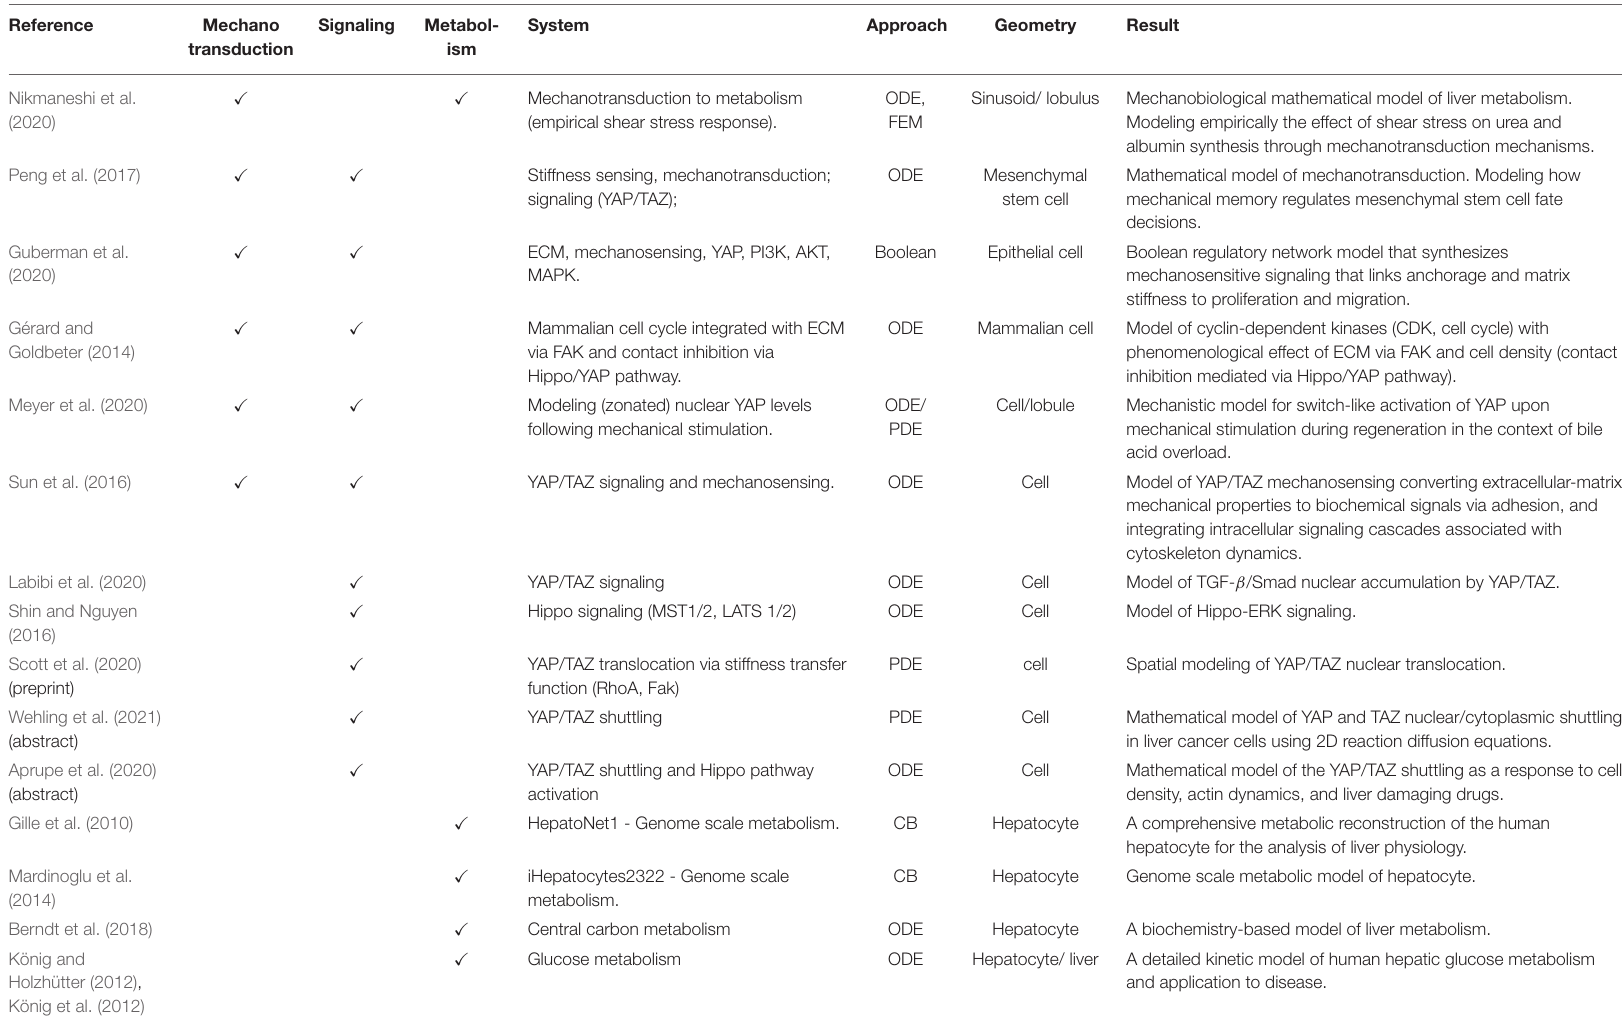
TABLE 7 | Selection of computational models on cellular scale.